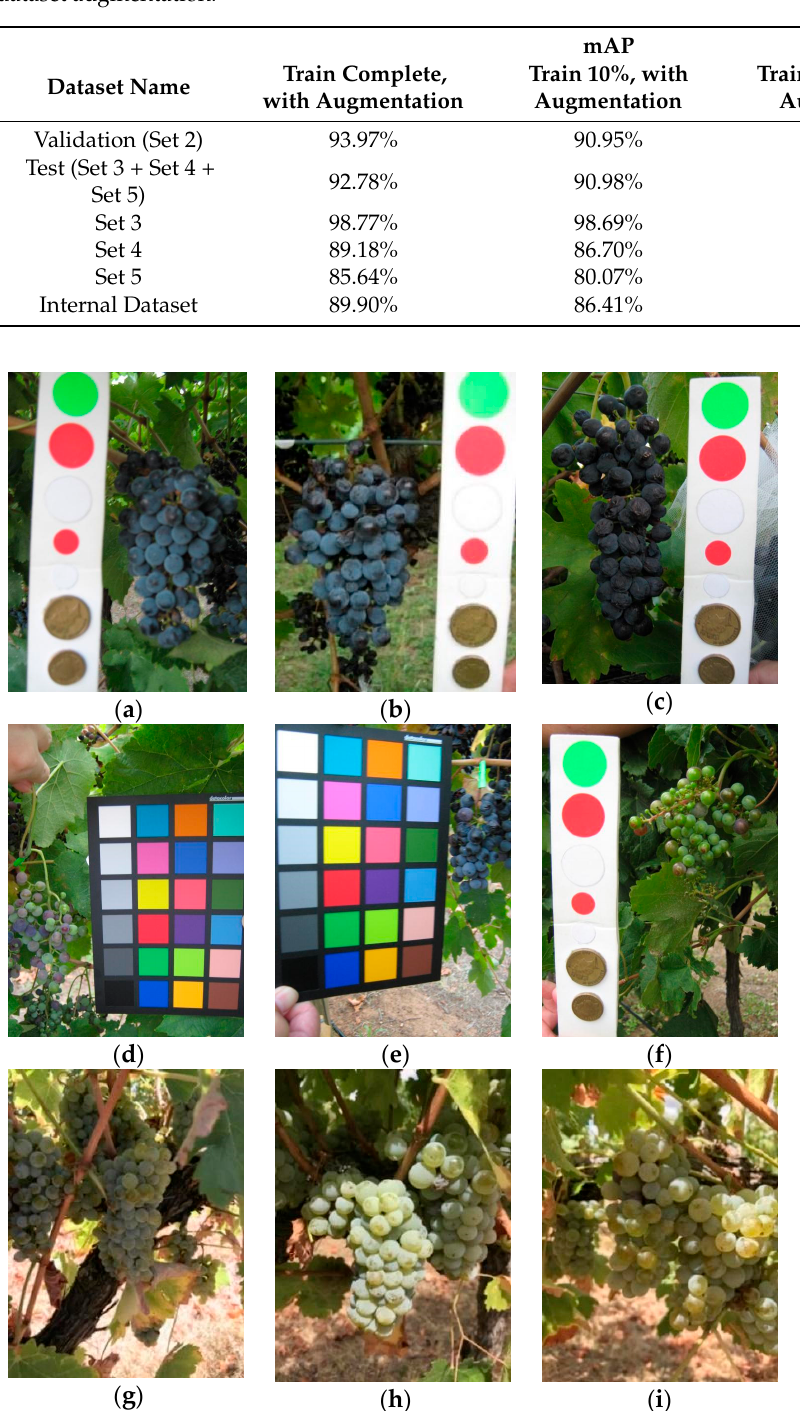
Table 4. Experimental results on both GrapeCS-ML and our internal dataset. The detector has been trained in three different ways: using the entire set 1 as train, with dataset augmentation; using only 10% of set 1 as a train, with dataset augmentation; using only 10% of set 1 as a train, without dataset augmentation.